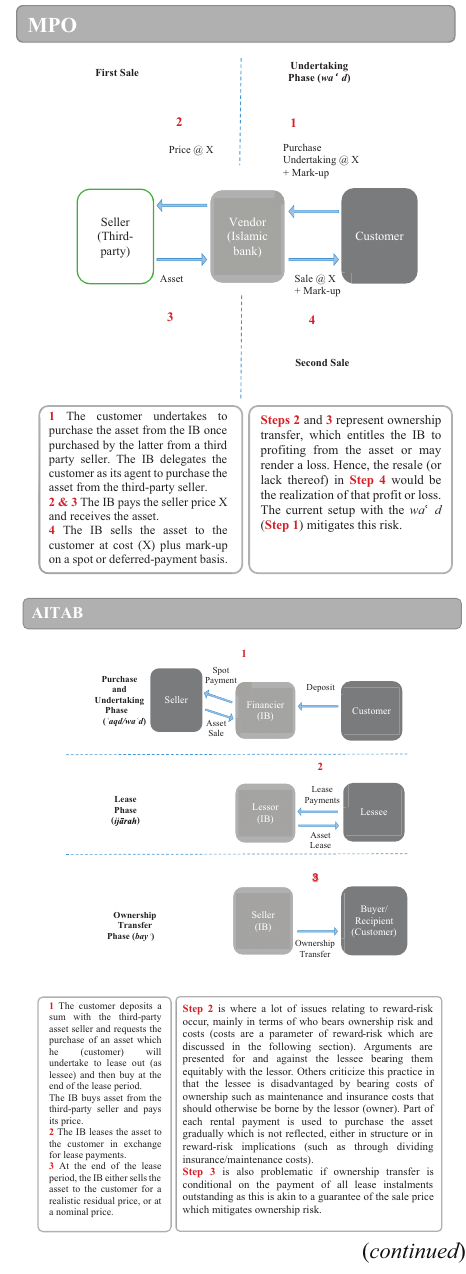
Figure 1. Reward-risk illustrations of MPO, AITAB and